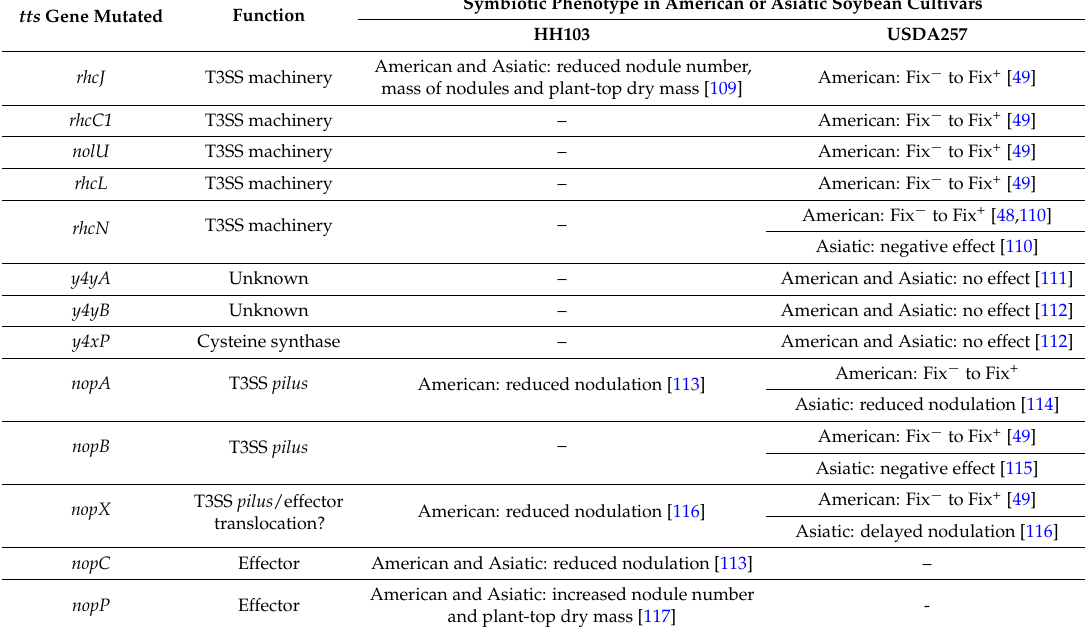
Table 2. Effect of the mutation of the Sinorhizobium fredii strains HH103 and USDA257 tts genes on soybean nodulation.